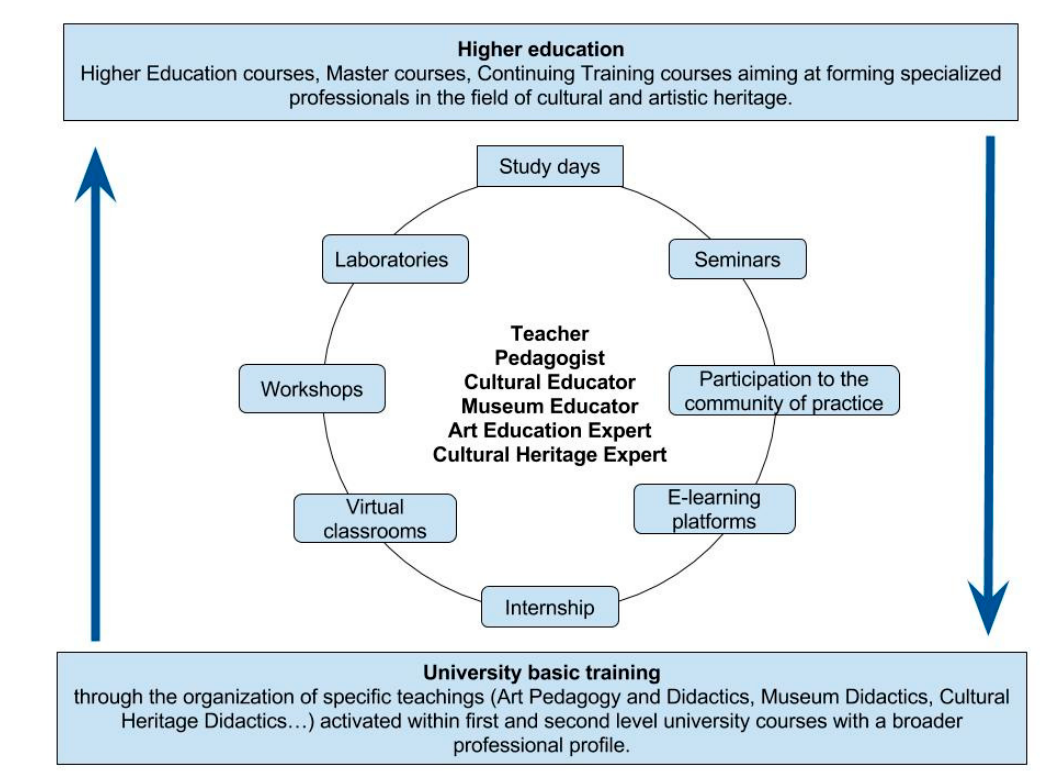
Figure 1. Integrated training model for museum educators, teachers, pedagogists and art education